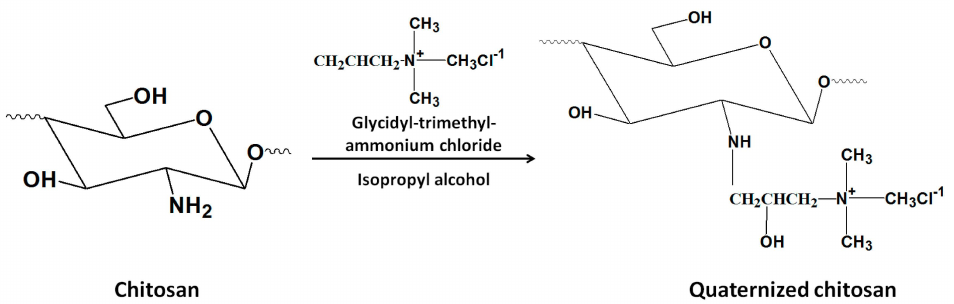
Figure 13. Preparation of N -(2-hydroxyl)propyl-3-trimethylammonium chitosan chloride